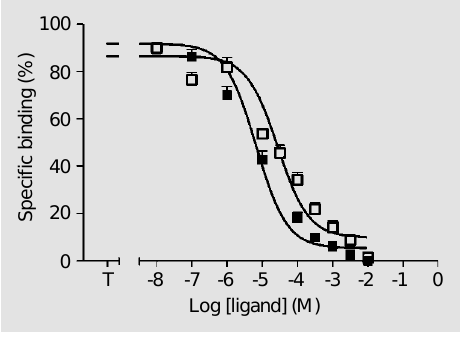
Figure 4. A , Cumulative concen- tration-response curves (1-h in- terval) for trimethylsulfonium in frog rectus abdominis muscle, in the absence (filled squares, N = 12) and in the presence of 1 µM d-tubocurarine (open squares, N = 9), 3 µM d-tubocu- rarine (inverted triangles, N = 8) and 10 µM d-tubocurarine (circles, N = 7). The antagonist was applied 1 h before the ago- nist. Data are reported as means ± SEM. B , Schild plot of the an- tagonism of the response of tri- methylsulfonium by d-tubocura- rine. The line was calculated by linear regression